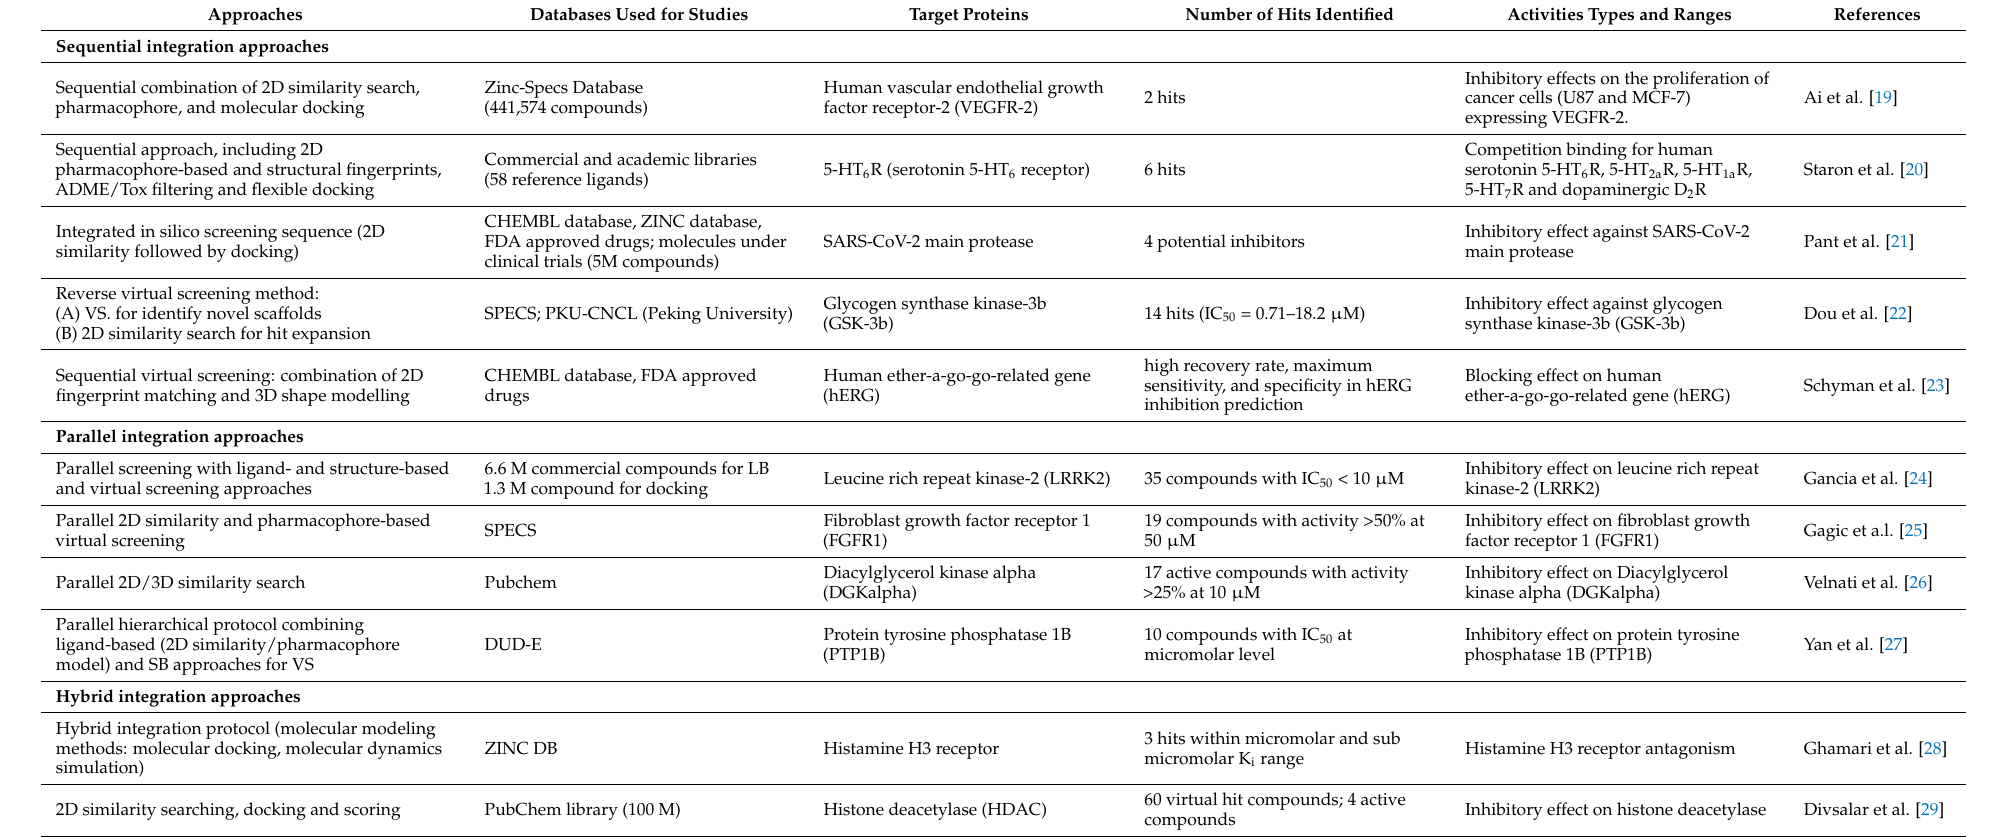
Table 3. Various integrated VS approaches from the recent